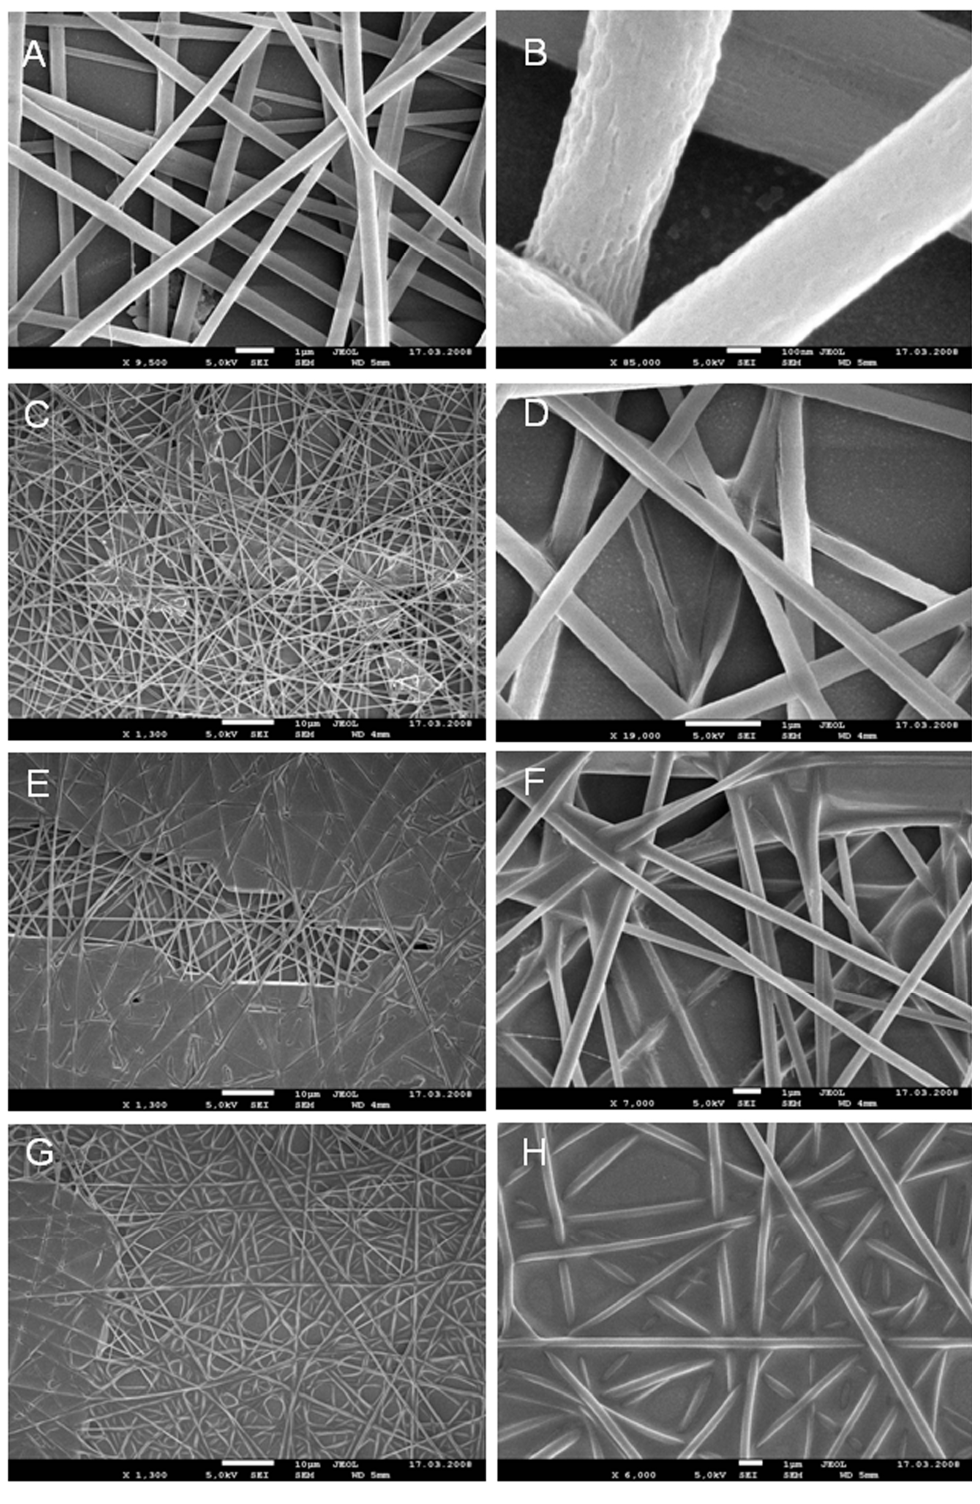
FIGURE 2 . Long-term stability of PLLA-COLI blend nanofibers in aqueous solutions. SEM analysis of PLLA-COLI blends (1:1) after incubation in aqueous solvents over a period of 4 (A,B), 8 (C,D), 12 (E,F), and 16 (G,H) days.